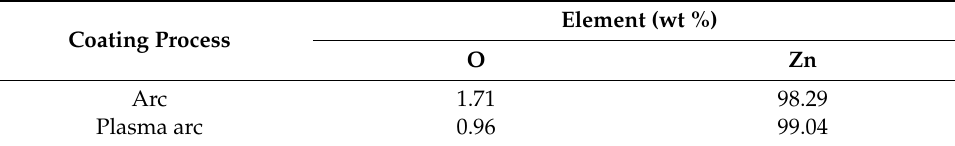
Figure 4. Cross-section SEM images of the zinc coating deposited by the ( a ) arc thermal spray and ( b ) plasma arc thermal spray processes at 500×. Table 3. EDS analysis of the Zn coating deposited by different processes. Table 3. EDS analysis of the Zn coating deposited by different processes.